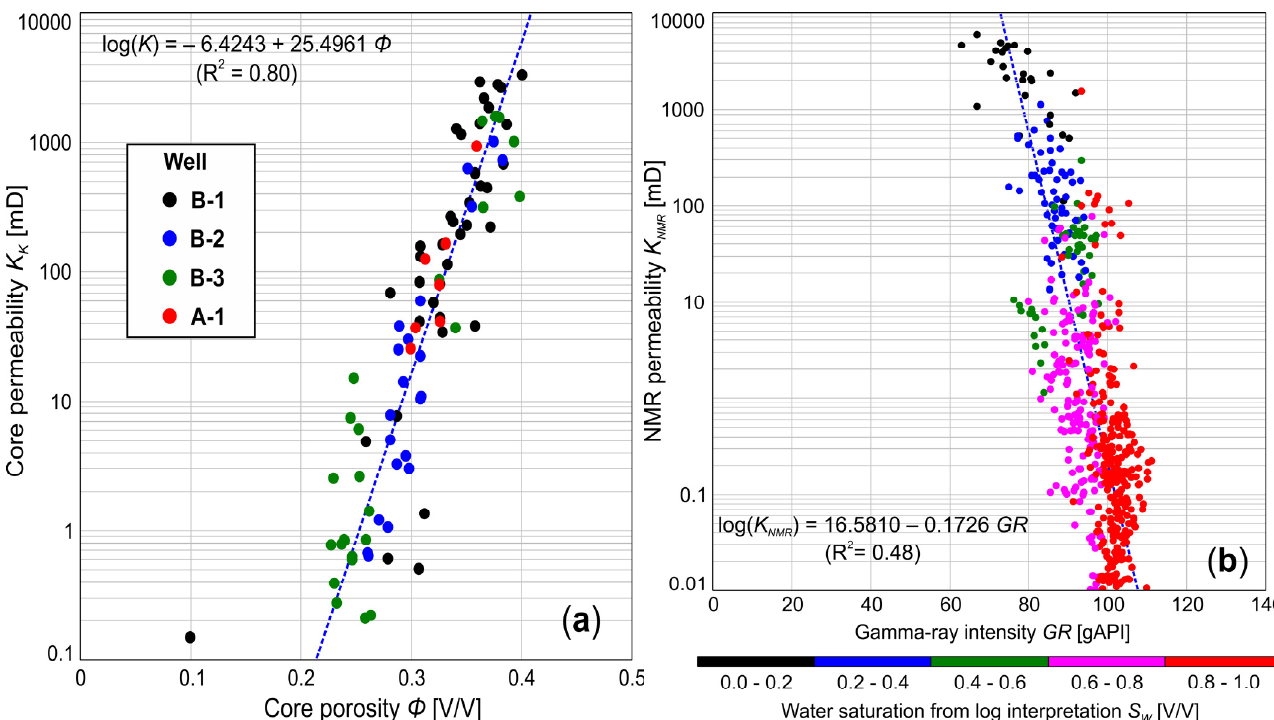
Figure 9. ( a ) Core permeability–core porosity relationship for the pre-reservoir, “Sand”, “Silt”, and post-reservoir deposits of “A” and “B” fields; ( b ) NMR permeability–gamma ray intensity dependence for the same sequence of deposits in the A-2 well (567 data levels). The color code corresponds to S w values resulting from the petrophysical interpretation of well